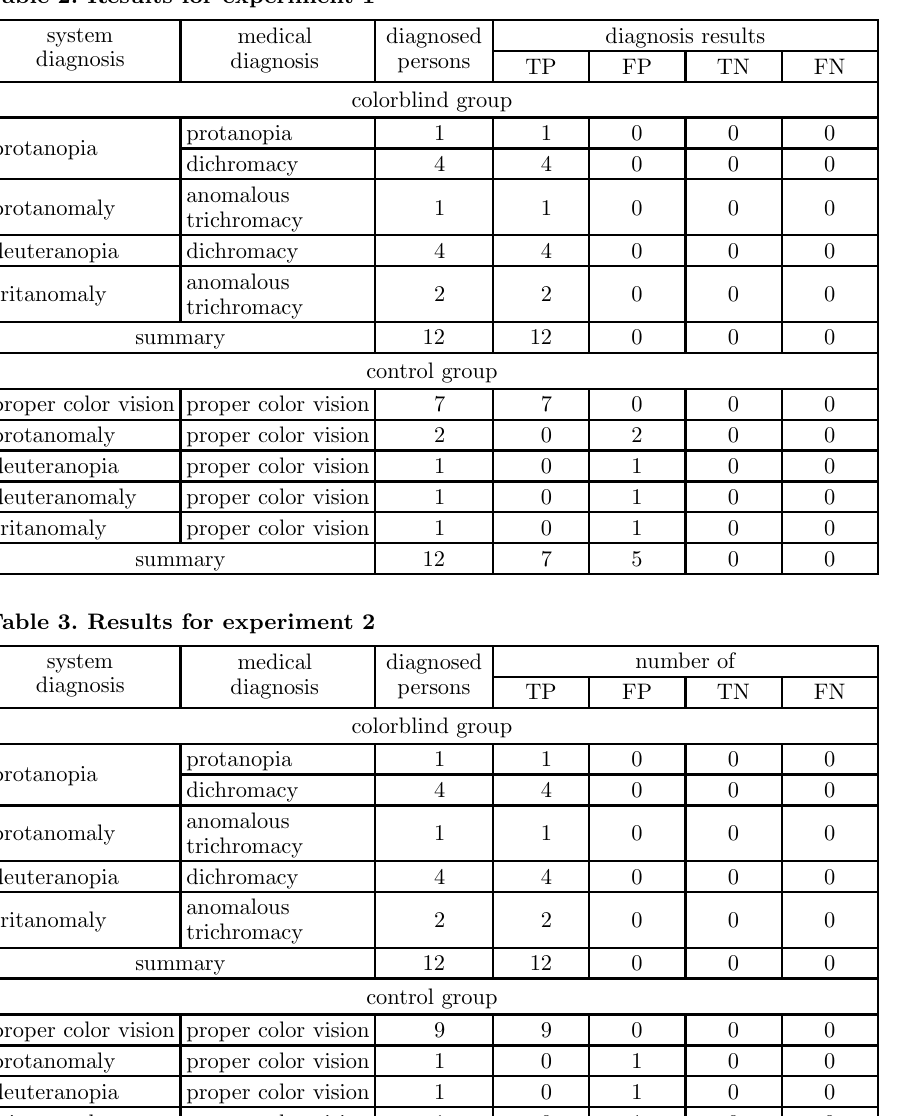
Table 2. Results for experiment 1